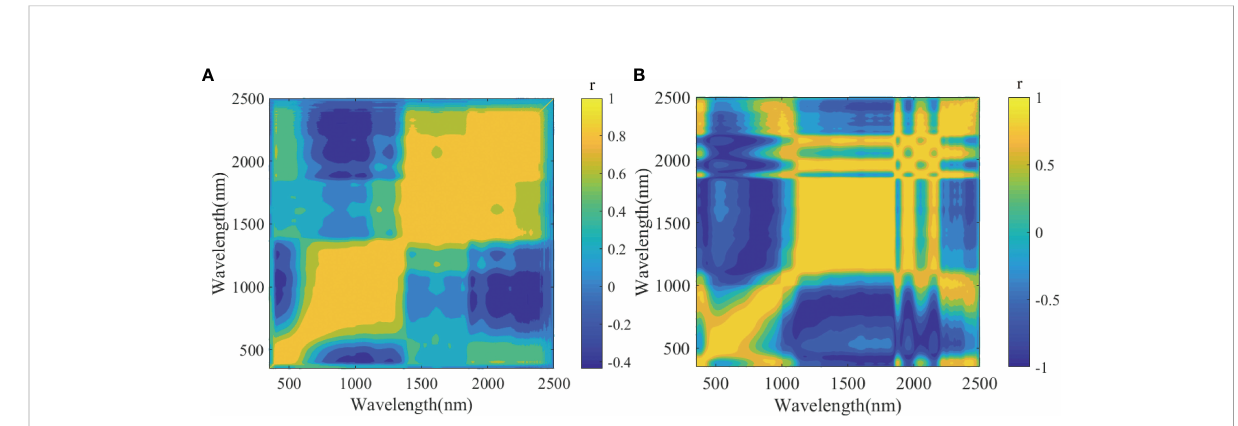
FIGURE 4 Two-dimensional correlation spectra of wavelengths for different spectral preprocessing. (A) Null. (B) SGS+SNV. r is the correlation coef fi cient to evaluate correlations between wavelength variables. SGS, Savitzky – Golay smoothing; SNV, standard normal variate.